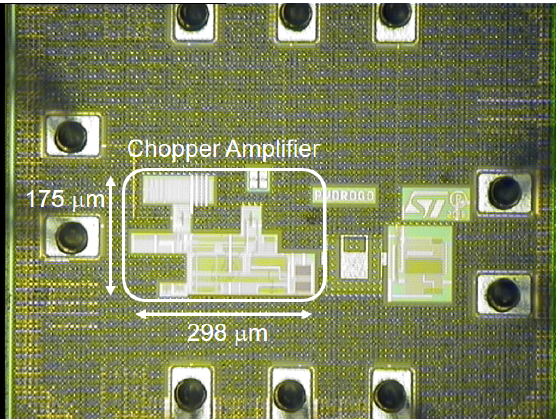
Figure 5. Microphotograph of the proposed test-chip prototype c (cid:13) 2019 IEEE [20].